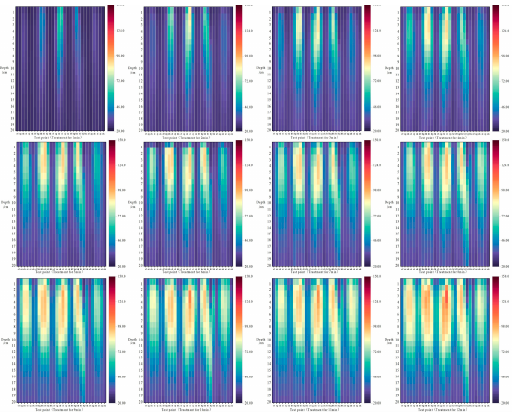
Figure 19. Heatmap of the internal temperature of 15% black soil under microwave irradiation. The internal temperature of loess and black soil irradiated by microwaves for 1~12 min 15%, 20%, and 23% moisture content, it was found that when the soil moisture content was 10%, the interior of the two soils reached the maximum temperature value. After 12 min 141 ◦ C (loess) and 151.6 ◦ C (black soil), which were obtained 3 cm and 4 cm away